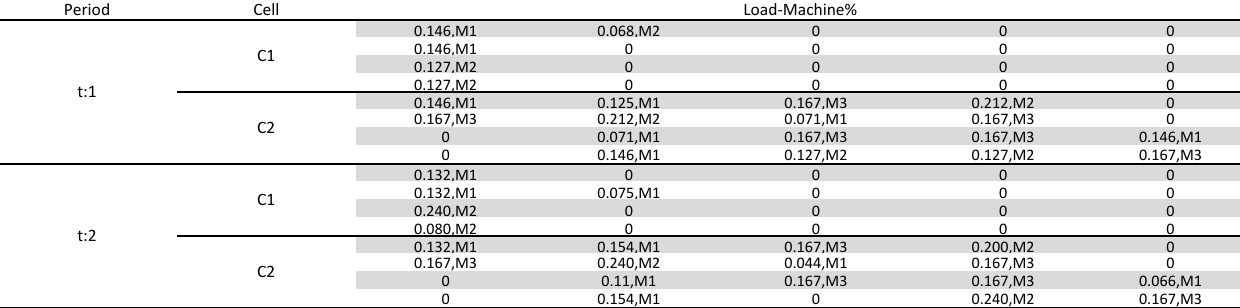
Results of machine-loads percentage in second planning period of final solution of experiment number 1 Period Cell